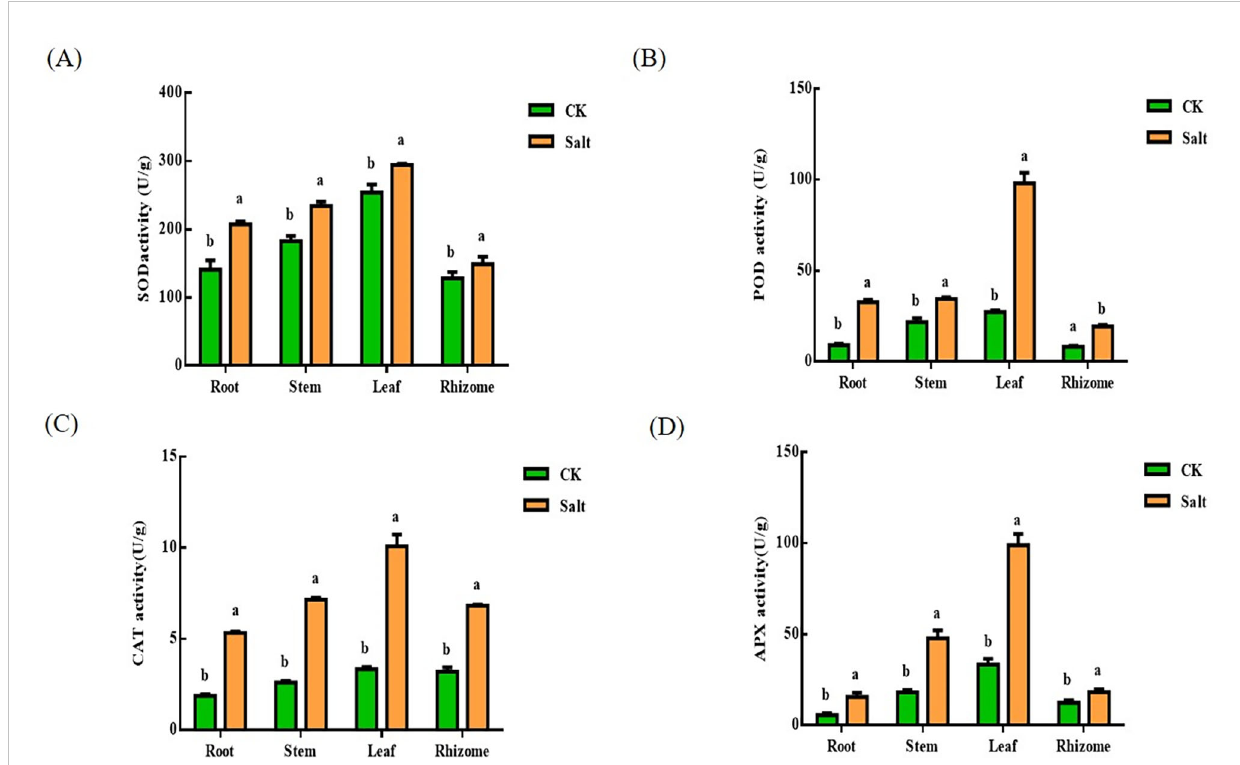
FIGURE 4 Effects of salt stress on SOD, POD, CAT and APX contents in various parts of ginger seedlings. (A) The SOD content. (B) The POD content. (C) The CAT content. (D) The APX content. The lowercase letters a and b mean the letter markers for signi fi cant difference